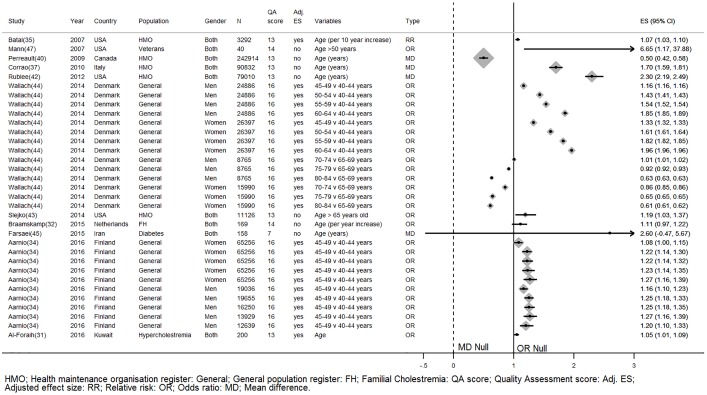
The relationship between age and statin adherence.*Wallach-Kildemoes; HMO: Health maintenance organisation; General: General population register; FH: Familial hypercholesterolemia; HC: Hypercholesterolemia; QA: Quality assessment; Adj. ES: Adjusted effect size; RR: Relative risk; OR: Odds ratio; MD: Mean difference.